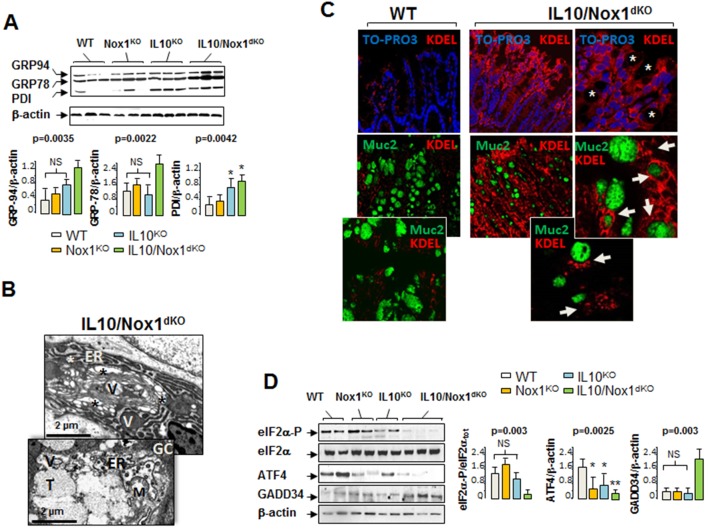
Evidence of altered UPR in IL10/Nox1dKO mice.(A) Representative immunoblot analysis of chaperone expression in the distal colon of 3–4-week old WT, Nox1KO, IL10KO, and IL10/Nox1dKO mice (n = 9/group) using an anti-KDEL antibody. β-actin was used as loading control and densitometric analyses are shown. P-values for Kruskal-Wallis non-parametric analysis are shown, Dunn’s multiple comparison test versus WT, NS; not significant. (B) Ultrastructural evidence of ER stress in the colonic epithelium of 4-week old IL10/Nox1dKO mice (n = 10). Representative transmission electron micrographs of goblet cells showing dilation of the endoplasmic reticulum (asterisks). Abbreviations: GC, goblet cell, ER, endoplasmic reticulum, T, thecae, M, mitochondria, V, vacuoles. (C) Confocal microscopy of colonic sections of WT and IL10/Nox1dKO mice stained with antibody against KDEL sequence (red) (upper panel). Original magnification (x40). The panel on the right-hand side represents a higher magnification (x60). Goblet cell thecae are identified by white asterisks. Nuclei (blue) are stained with TO-PRO-3 iodide. Lower panels: double indirect immunofluorescence of colonic sections of WT and IL10/Nox1dKO mice stained with antibodies against Muc2 (green) and KDEL sequence (red). Original magnification (x40). Photomicrographs are representative sections of five mice for each genotype. Inset boxes are enlarged views showing co-expression of both markers in goblet cells (white arrows). Original magnification (x60). (D) Representative immunoblot analysis of indicated protein expression in the distal colon of 3–4-week old WT, Nox1KO, IL10KO, and IL10/Nox1dKO mice (n = 9/group). β-actin served as a loading control. The P-eIF2β/eIF2β ratio was measured and densitometric analyses are shown. Statistics are as in (A).